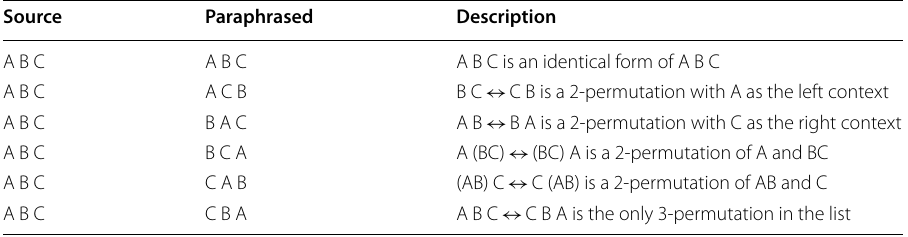
Table 4 Permutation patterns for 3-permutations of identical textual segments